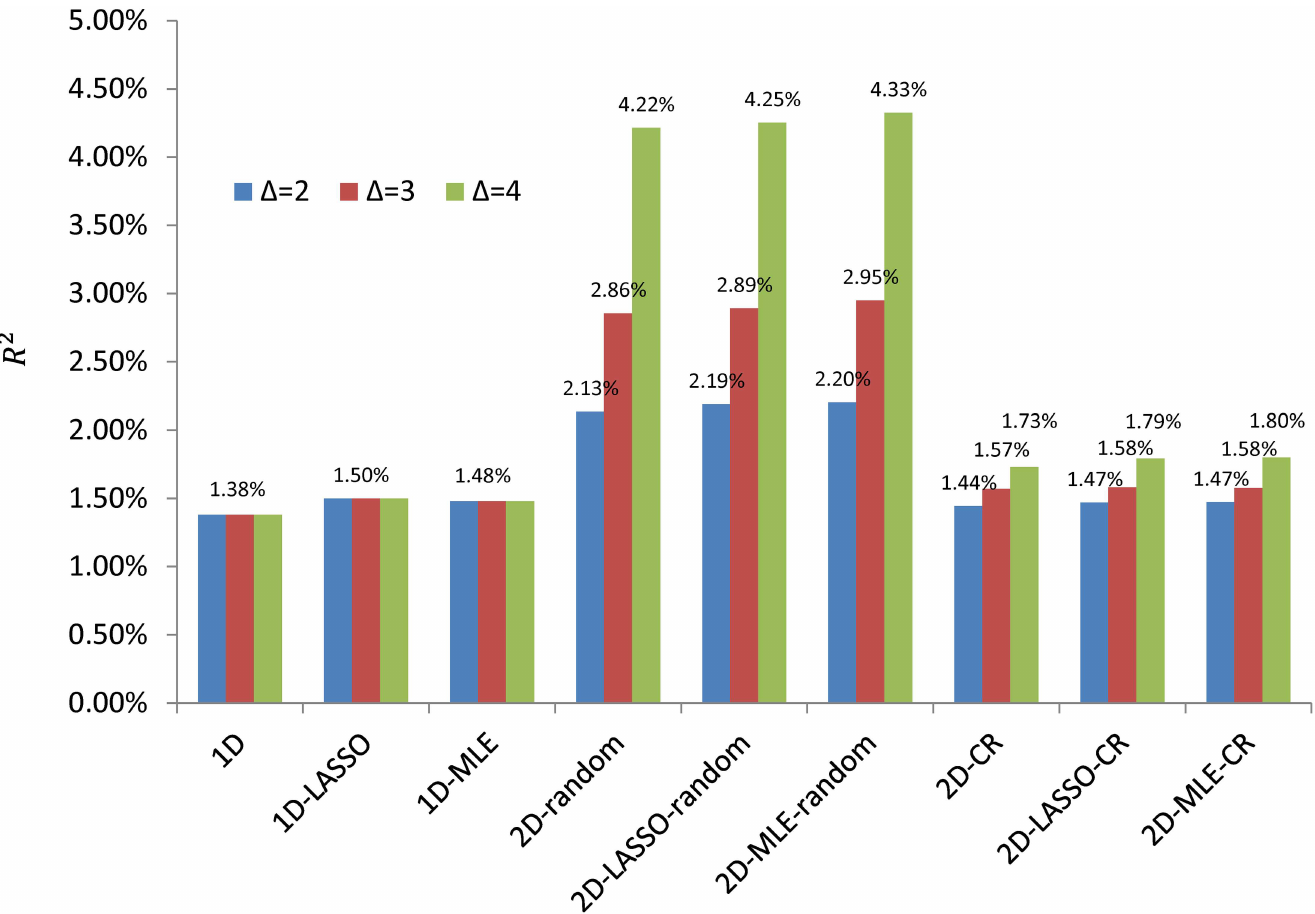
Fig 2. Simulation results for comparing polygenic risk prediction methods and different high priority SNP sets. Quantitative traits were simulated conditioning on the genotypes of LD-pruned SNPs in lung cancer GWAS with 10,000 discoverysamples and 1,924 validation samples. For each simulation, we used 5,000 causal SNPs and 9,940 high priority (HP) SNPs (either randomly selectedor the SNPs related with conservedregions). Δ denotesthe enrichment fold changeof the HP SNP. In the x-axis, “1D” denotes1D PRS without winner’scurse correction;“1D-LASSO(MLE)” denotes1D PRS with lasso-type (MLE) correction; “2D-random” indicates2D PRS with HP SNP sets randomly selectedfrom the LD-prunedSNPs in the genome; “2D-CR” indicates 2D PRS using SNPs in conservedregions as HP SNPs.